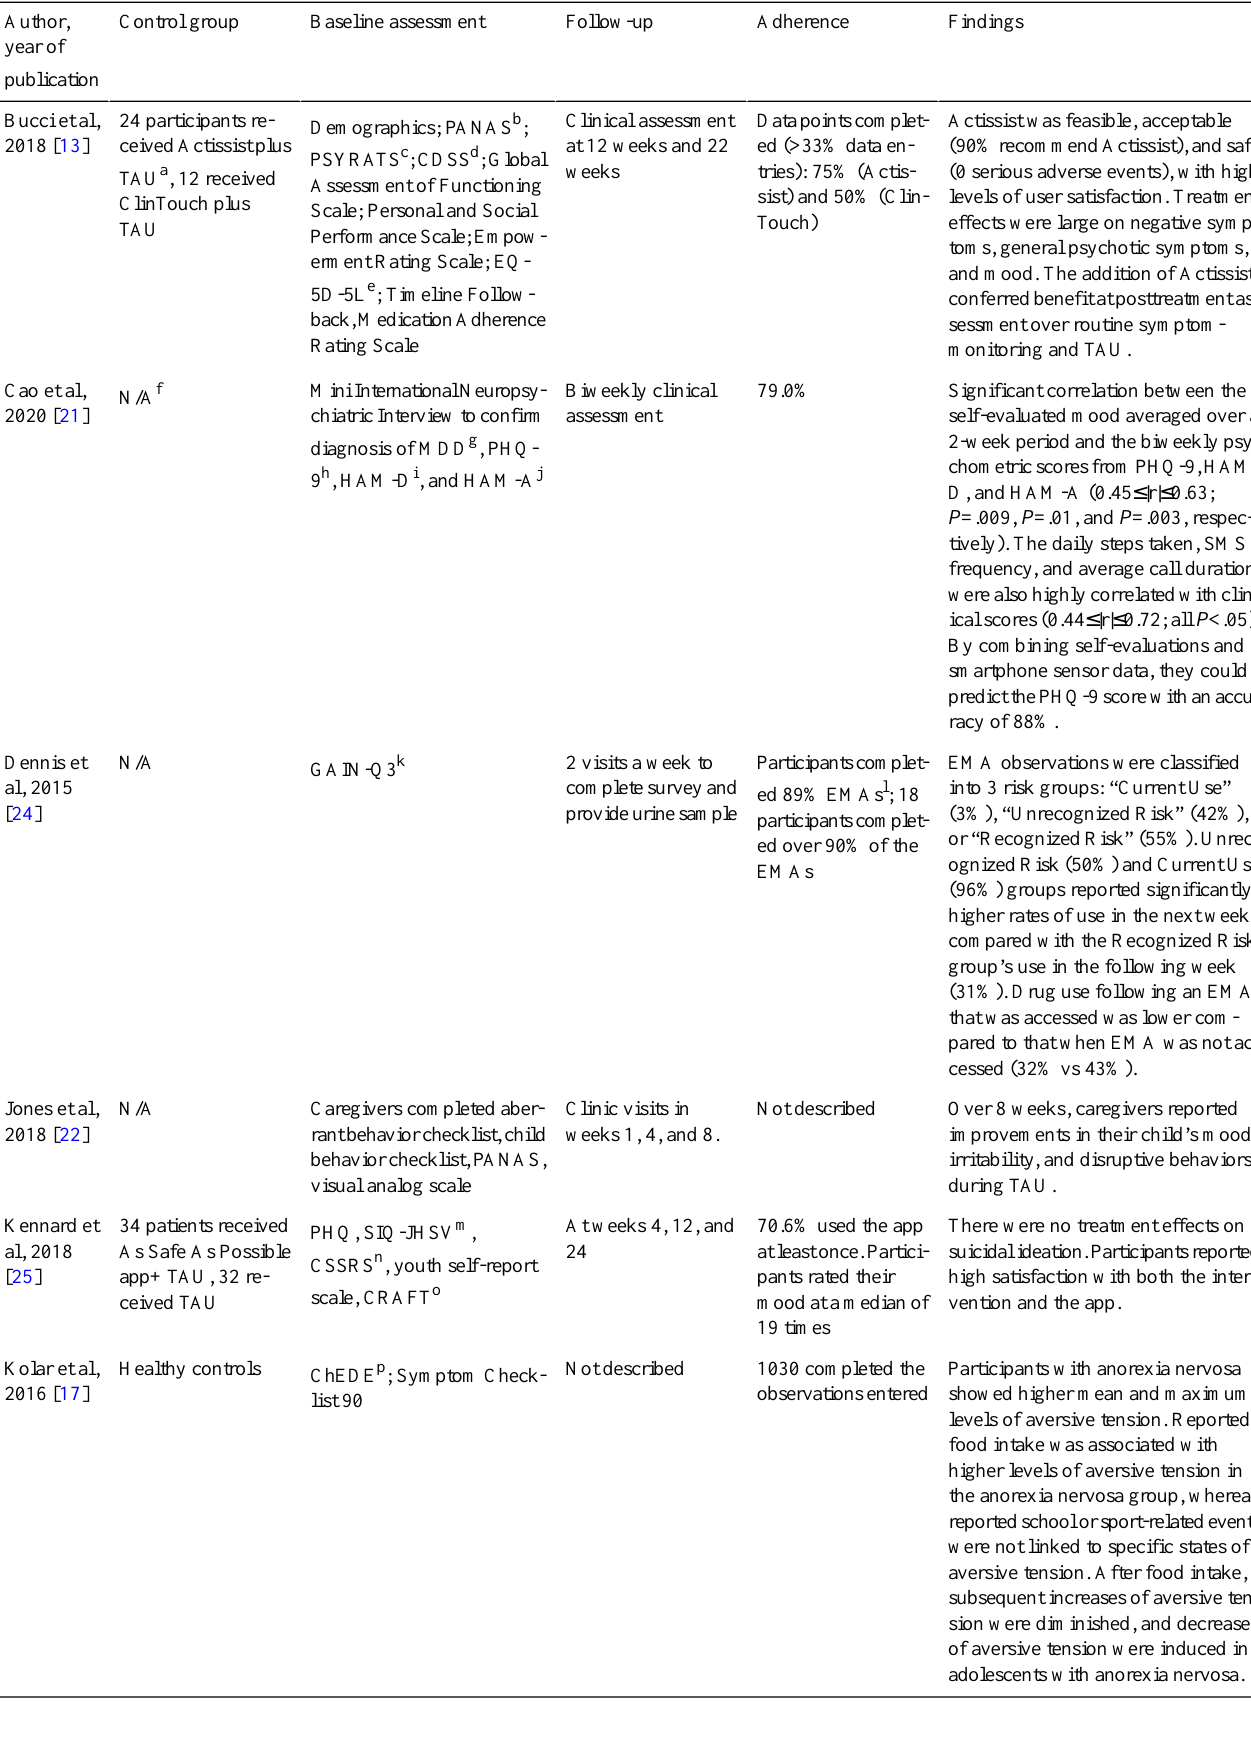
Table 3. Description of the control groups, procedures, and findings in studies on self-monitoring, treatment, and automatically generated data collected via smartphones in children, adolescents, and young adults with psychiatric disorders